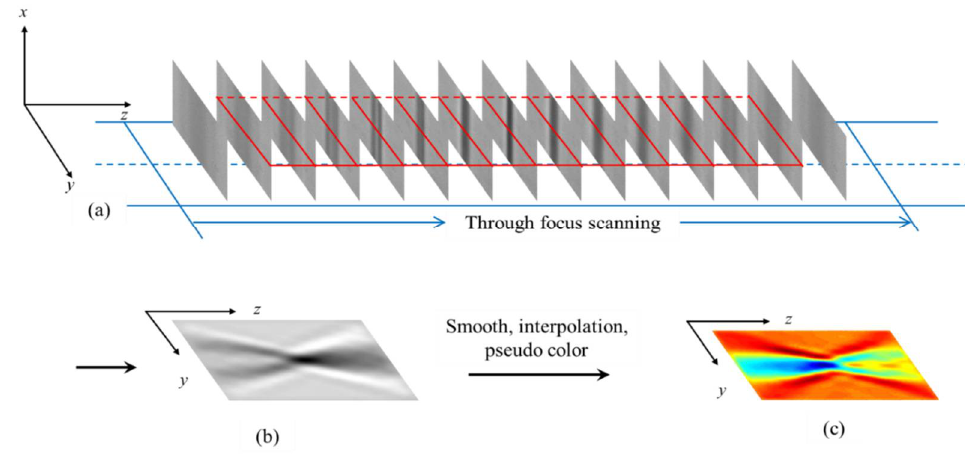
Figure 8. Generation of TSOM image. ( a ) The transverse sectional view in the middle of the cube; ( b ) Spliced sectional view; and ( c ) TSOM image obtained after smoothing, interpolation and pseudo- color processing.